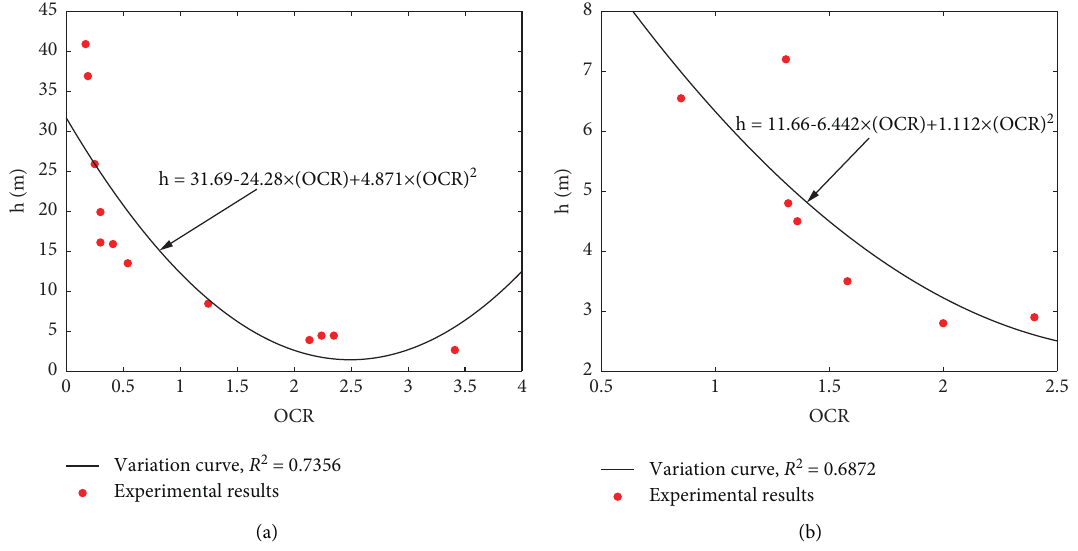
Variation curve, R 2 = 0.7356